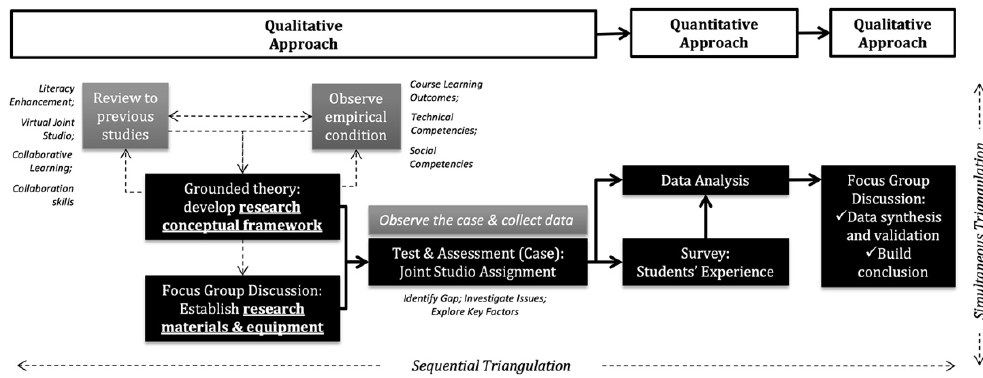
Figure 1. Illustration of research methodology and flow.